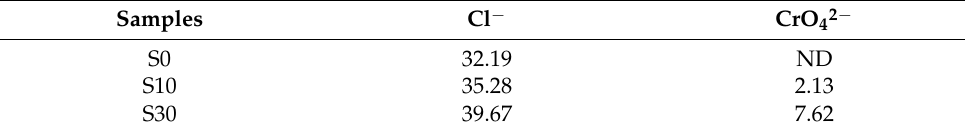
Figure 6. XRD spectra of different samples (F10, F20, F30). Table 6. Leaching concentrations of Cl − and CrO 42 − in the samples (ppm).